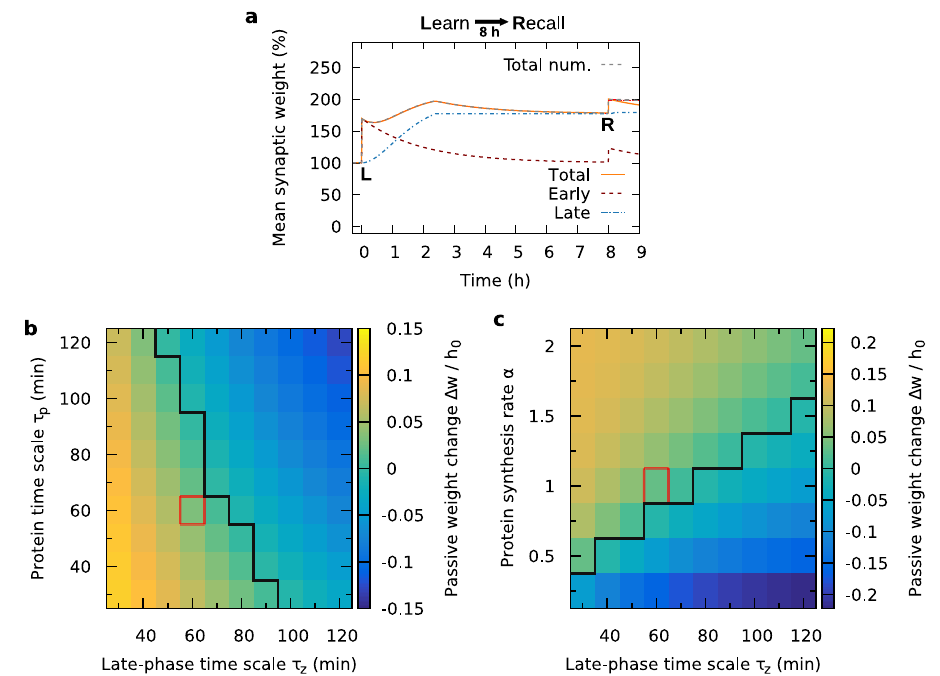
Fig. 8 Analytical investigation of the long-term weight dynamics and passive improvement depending on late-phase time constants. a The early-phase values immediately after learning ( “ L ” ) and after recall ( “ R ” ) were taken from the average over numerical simulations (Fig. 6b) and inserted into the analytical equations for the late-phase dynamics (Eq. (5)) and the early-phase decay (Eq. (3)). The curves are in very good match with the simulated results, the total weight of which is shown here for comparison by the dashed gray line (cf. Fig. 6b). b , c Varying the time constants for late-phase dynamics τ τ α ( c ), shows that for slower time scales and lower synthesis rate, the passive weight z and protein amount p ( b ), as well as the protein synthesis rate change becomes negative, i.e., there is a passive deterioration instead of improvement. The black separatrix line demarcates the two regimes of improvement and deterioration. The red boxes indicate the parameter values used in our numerical